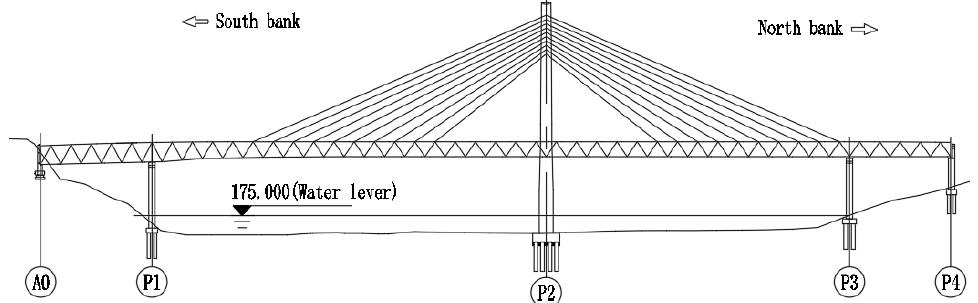
Figure 3. The overall drawing.